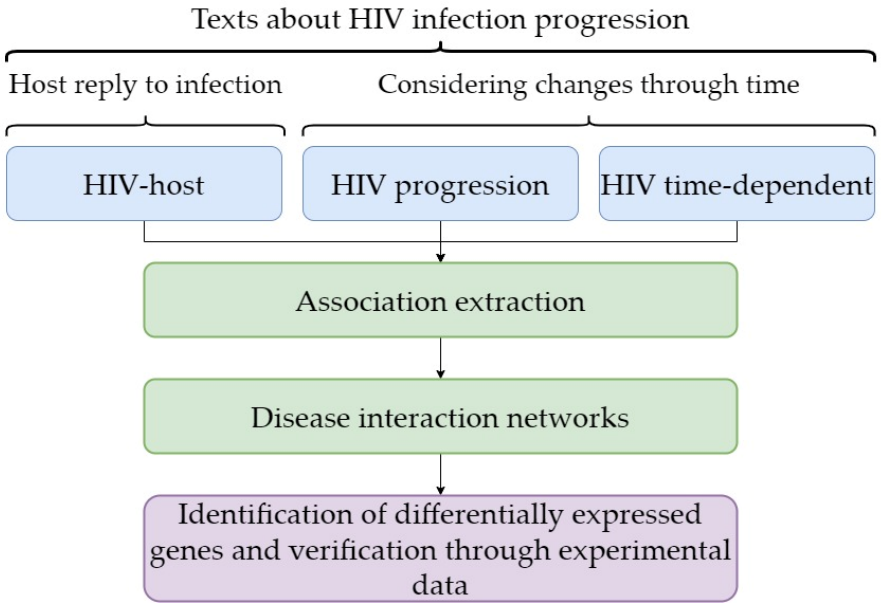
Figure 4. The principal components of the workflow used in the